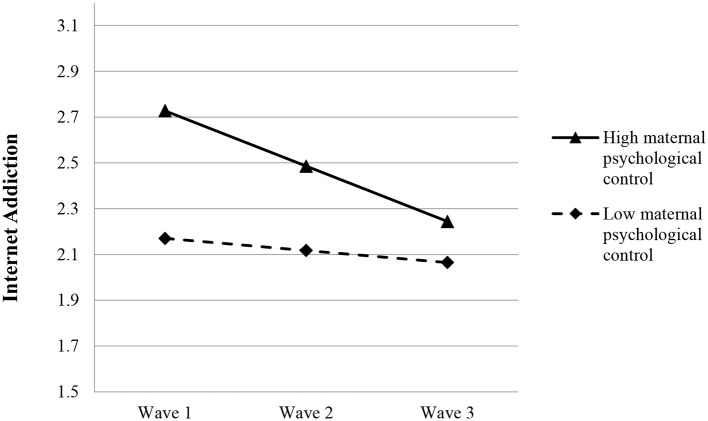
Growth trajectories of adolescent Internet addiction as a function of maternal psychological control. The figures were plotted based on Model 4b shown in Table 5. High level indicates 1SD higher than the mean value; low level indicates 1SD lower than the mean value.